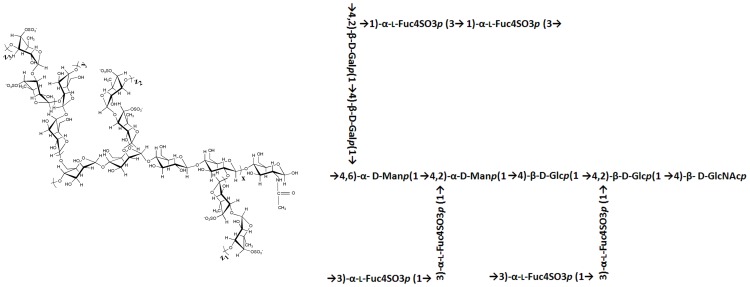
The possible structure interpreted for HFC polysaccharide.